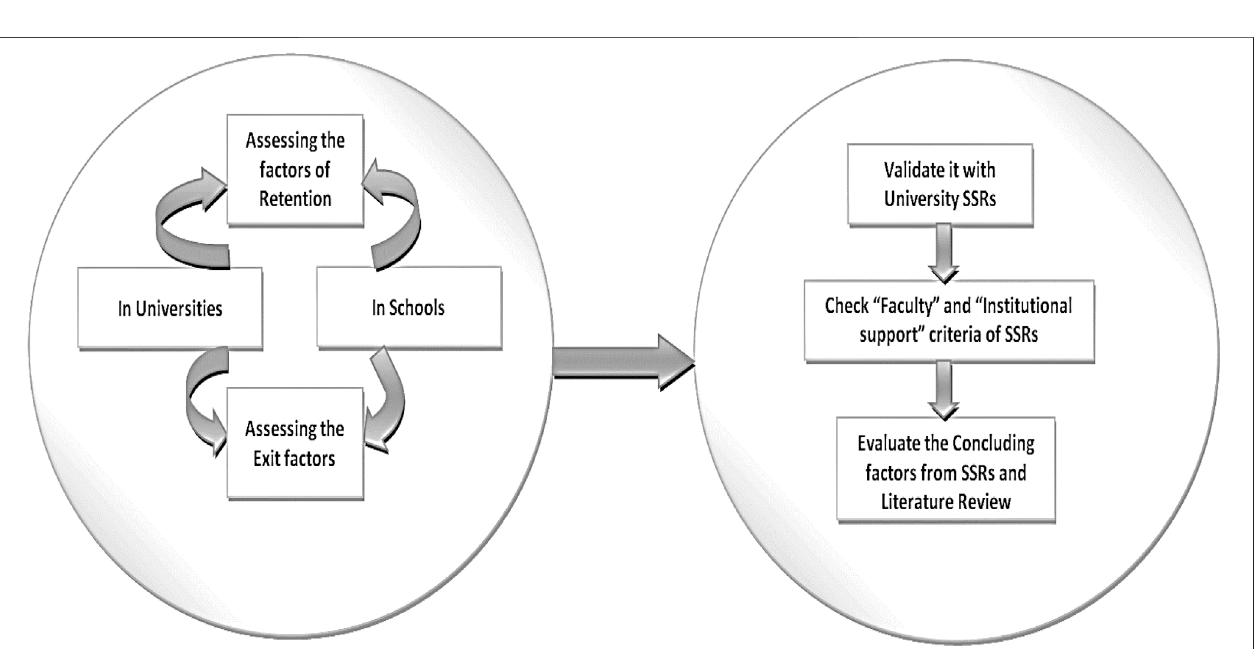
FIGURE 2 | Architectural diagram for checking the factors of